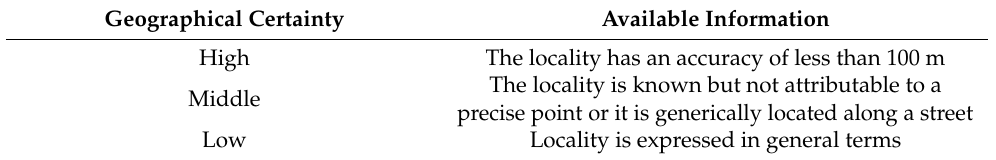
Table 2. Geographical certainty range. Geographical Certainty Available Information High The locality has an accuracy of less than 100 m The locality is known but not attributable to a Middle precise point or it is generically located along a street Low Locality is expressed in general